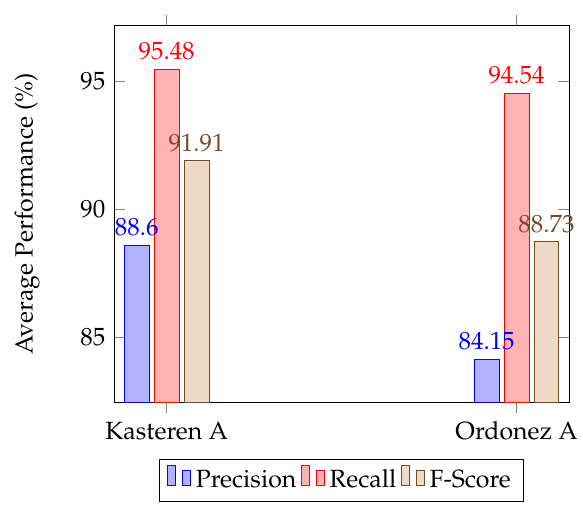
Figure 8. Average precision, recall and F-Score for Kasteren A and Ordonez A datasets.